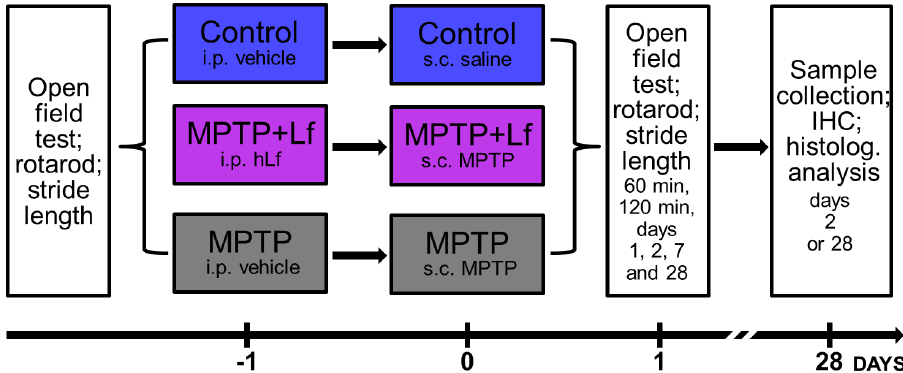
Figure 1. Experimental timeline. C57Bl/6 mice received an intraperitoneal injection of human Lf (i.p.; twice, 24 and 3 h before MPTP). MPTP (40 mg/kg) was administered once subcutaneously (s.c.). Behavioral and functional tests were performed prior to injections and 60 min, 120 min, 1, 2, 7, and 28 d after administration of MPTP/saline. On days 2 or 28, the animals were transcardially perfused; the brains were removed for immunohistochemical (IHC)